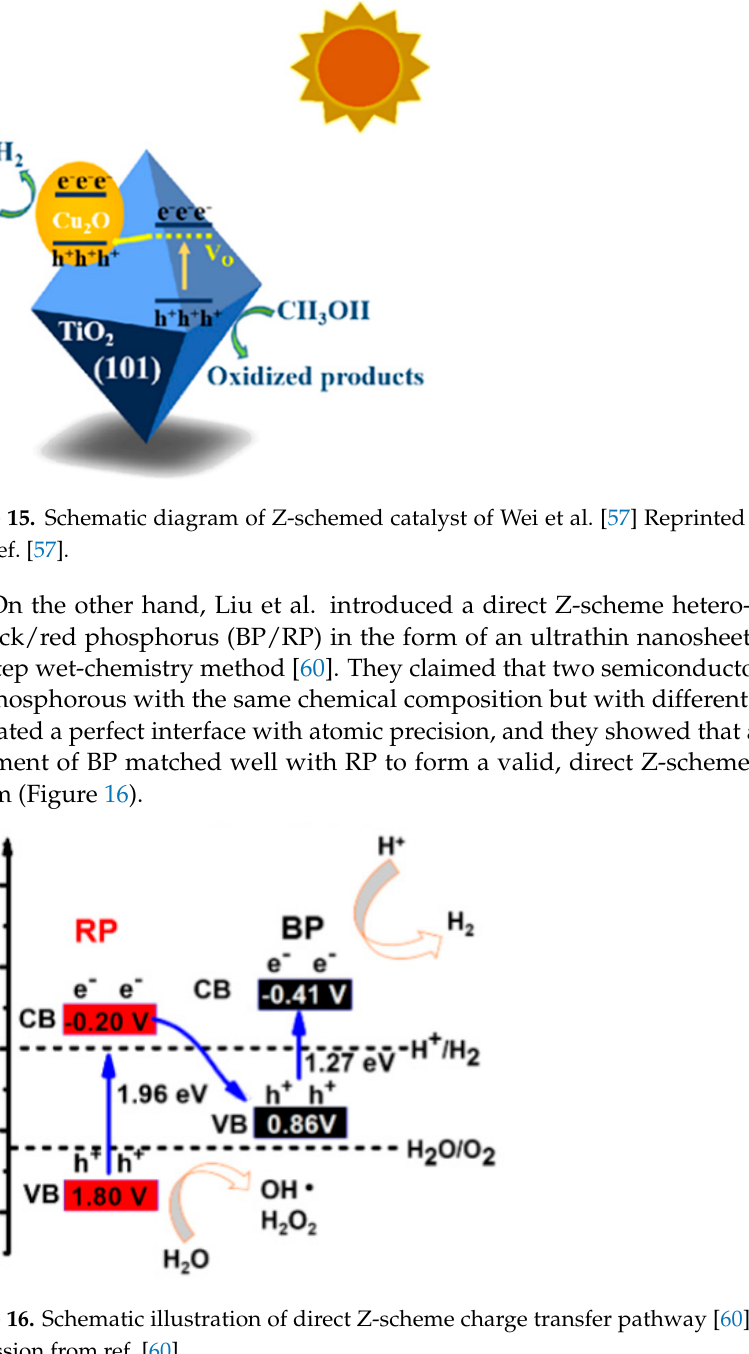
Figure 16. Schematic illustration of direct Z-scheme charge transfer pathway [60]. Reprinted with permission from ref. [60].